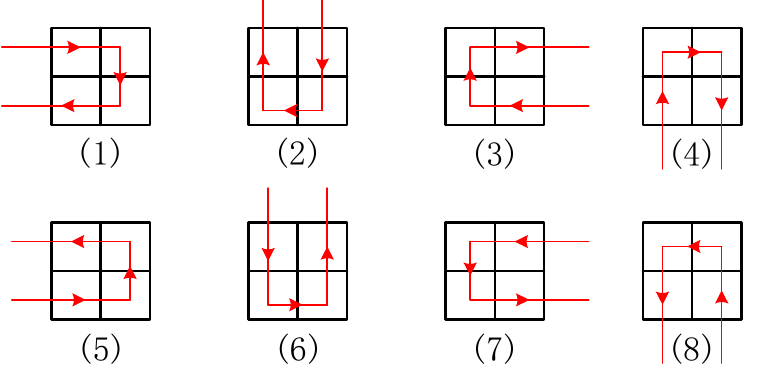
Figure 6. Eight 1-order Hilbert curves.